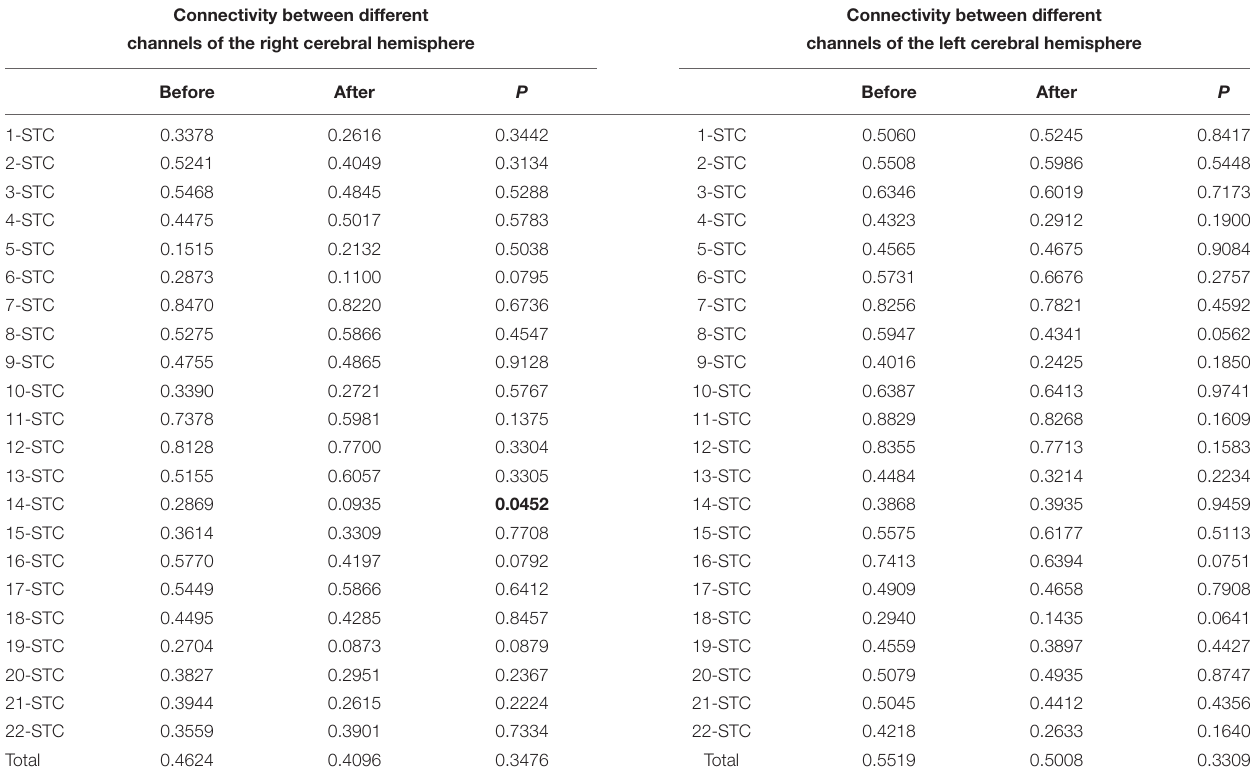
The bold values indicates the degree of the connectivity between two areas, and with values approaching 1 indicating higher connectivity.